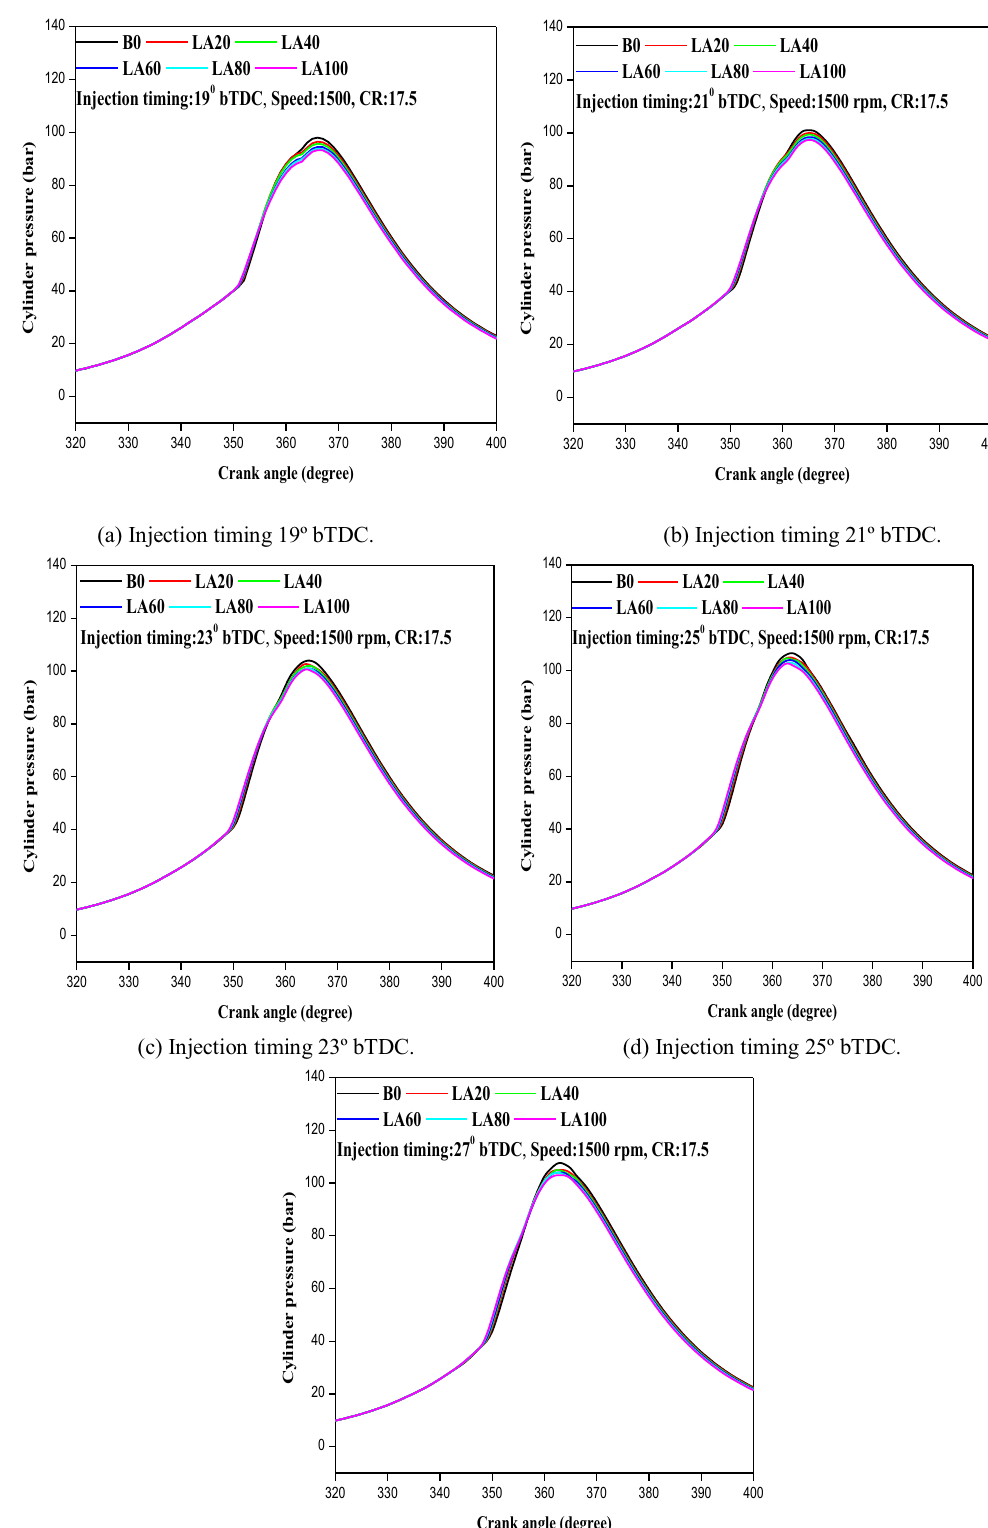
Figure 7. ( a–e ) The variation in-cylinder pressure with different FITs and engine load for considered fuel